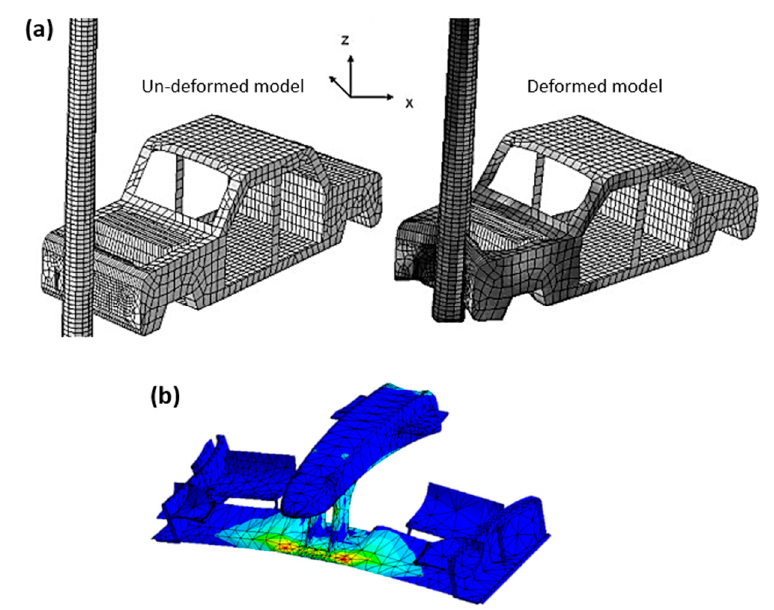
Figure 41. Some applications of FEM in composites in the automotive sector: ( a ) impact. Reproduced with Creative Common License [266], and ( b ) car racing.